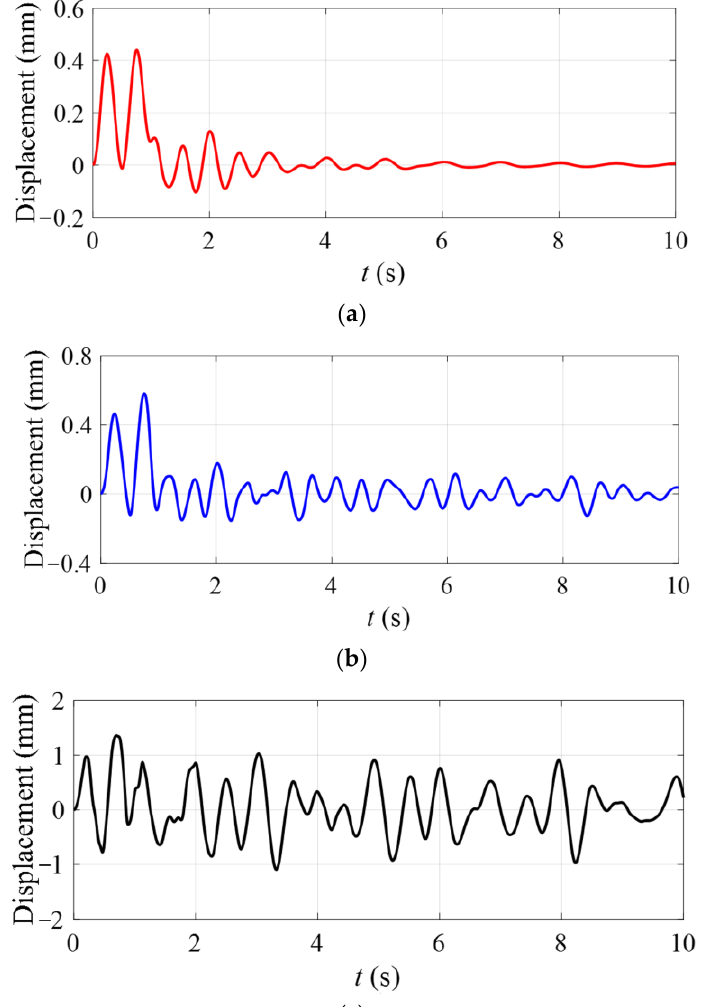
Figure 5. Time responses of the out-of-plane displacement of point A . ( a ) ω 0 = π/5 rad/s; T = 1 s; α = β = 0.01. ( b ) ω 0 = π/5 rad/s; T = 1 s; α = β = 0.001. ( c ) ω 0 = π/2 rad/s; T = 1 s; α = β = 0.001.